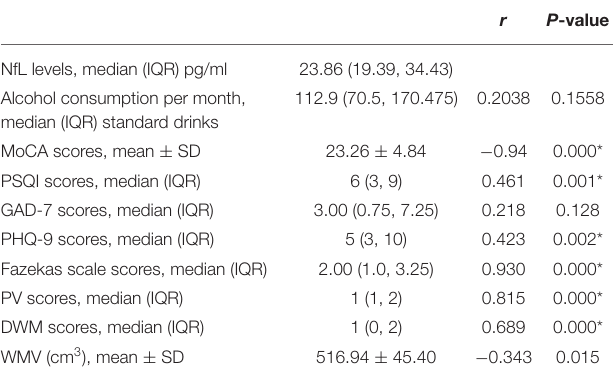
TABLE 2 | Relevance analysis of serum NfL levels and alcohol assumption, neuropsychological function, the severity of WMLs, and WMV in the alcohol dependence